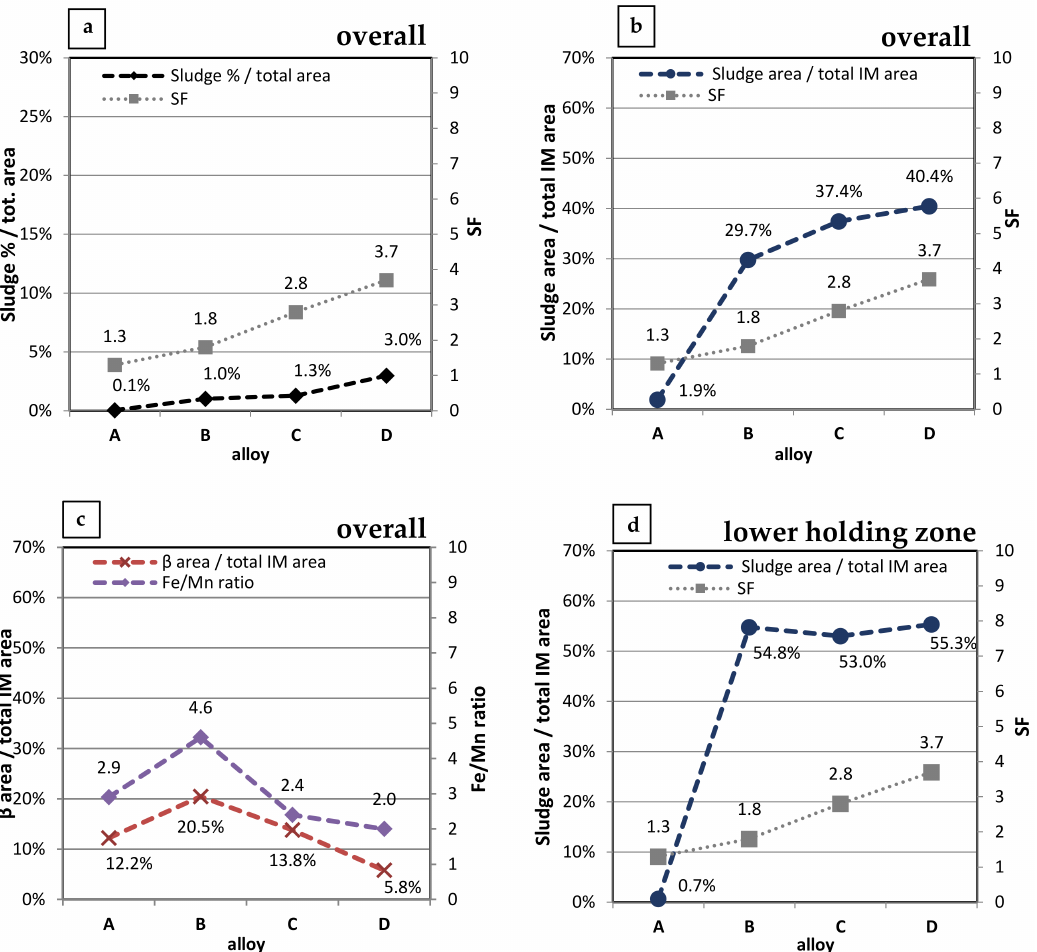
Figure 5. Results of optical images analyses, showing ( a ) the relation between SF and percentage of area covered by sludge particles; ( b ) correspondence between SF and sludge IM fraction calculated on the overall length of the sample; ( c ) variation of β -Fe IM fraction with Fe/Mn ratio and ( d ) the relation between sludge IM fraction and SF in the lower holding zone of fatigue